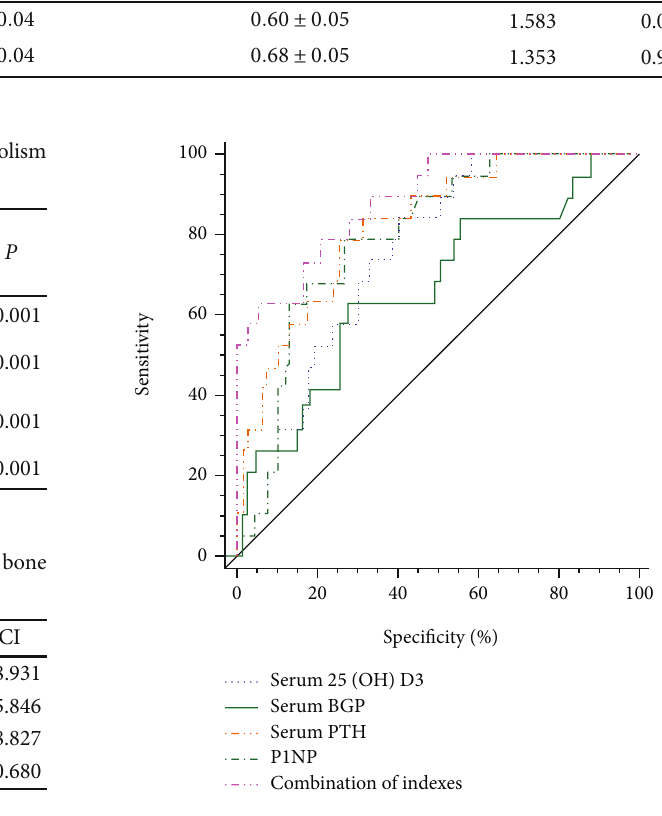
Figure 1: ROC curves of the biochemical indexes of bone metabolism for